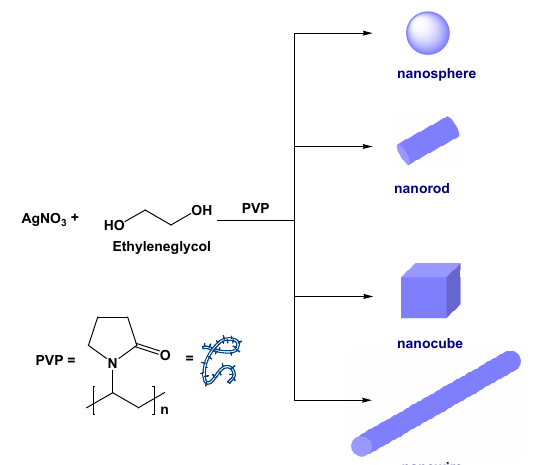
Figure 8. TEM micrographs of silver nanorods and nanowires (up). Synthesis of unidimensional silver nanostructures using CTAB micelles (TEM micrographs adapted from [34] with permission of the The Royal Society of